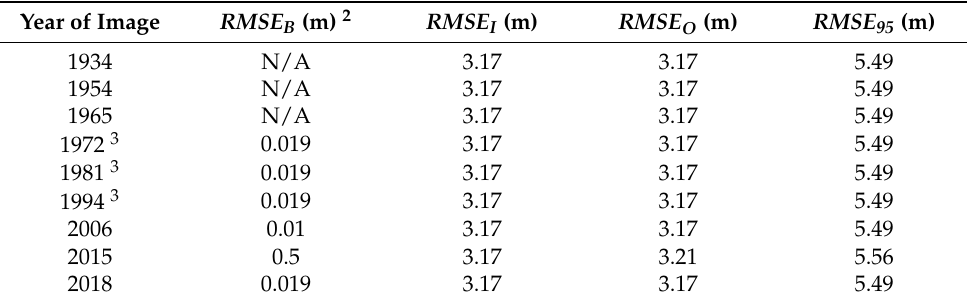
Table 2. Summary of the root mean square errors for the base imagery ( RMSE B ), georeferencing ( RMSE G ) 1 , interpretation ( RMSE I ), overall coastline position ( RMSE O ) and 95% confidence interval ( RMSE 95 ) for each aerial photograph selected for the study. Year of Image RMSE B (m) 2 RMSE I